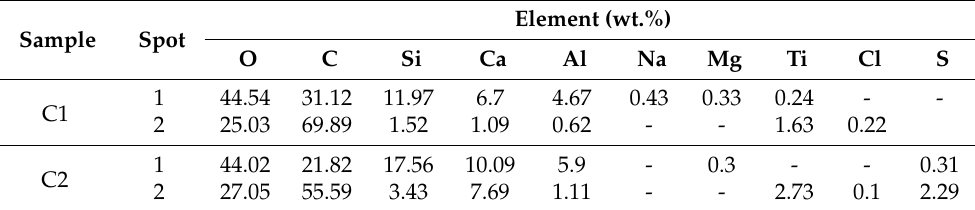
Table 3. Elemental composition of the samples obtained by EDS.